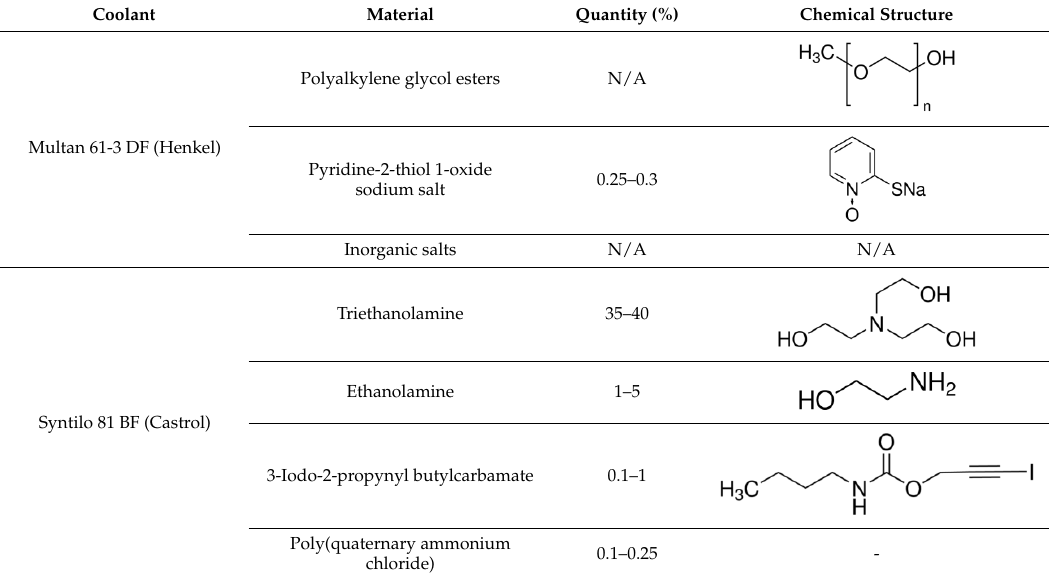
Table 1. Chemical composition of industrial grade coolant fluids, Syntilo 81BF and Multan 61-3 DF. Coolant Material Quantity (%)